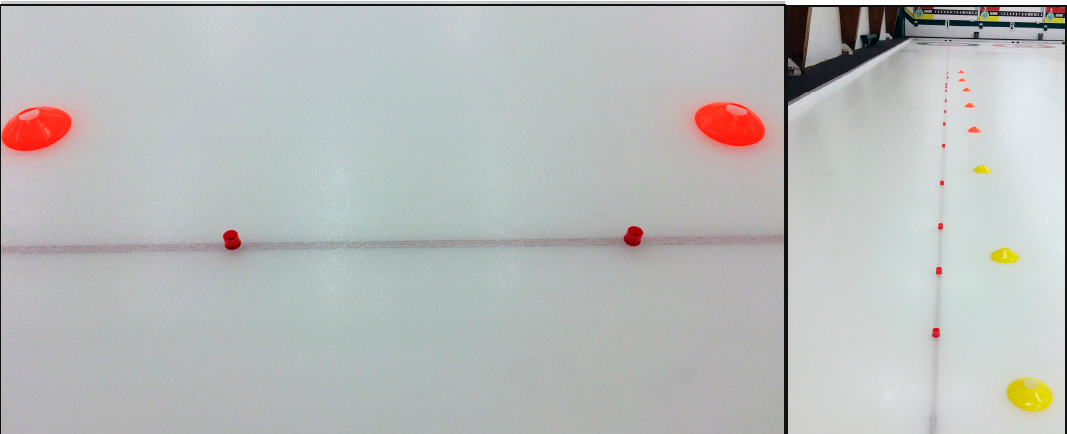
Figure 1. Placement and setting of the ice replicas along the centerline of a single sheet, where one broom was used between two pylons and two replicas were collected with